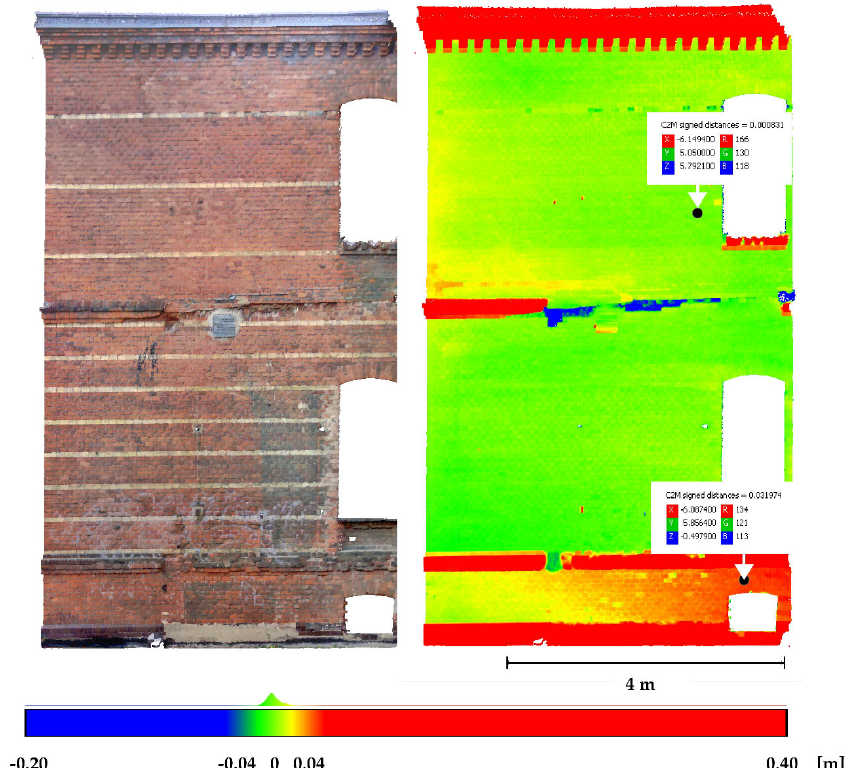
Figure 10. Deviation analysis of the wall.